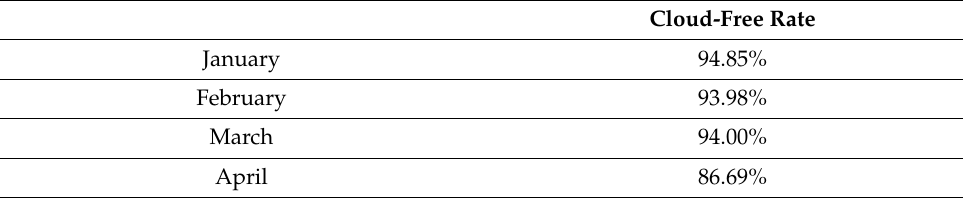
Table 4. The cloud-free rate for each